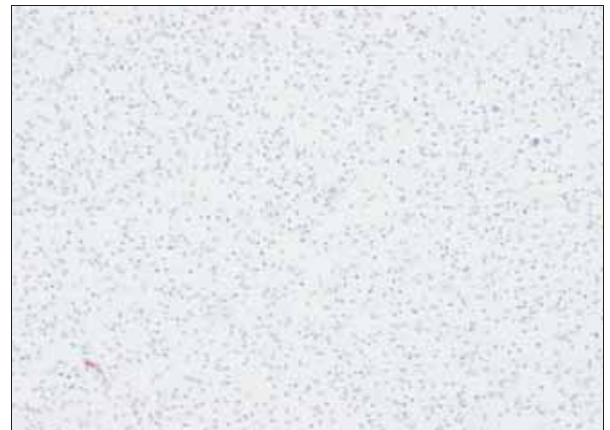
Figure-5b: Microphotograph showing as coccobacillary bipolar